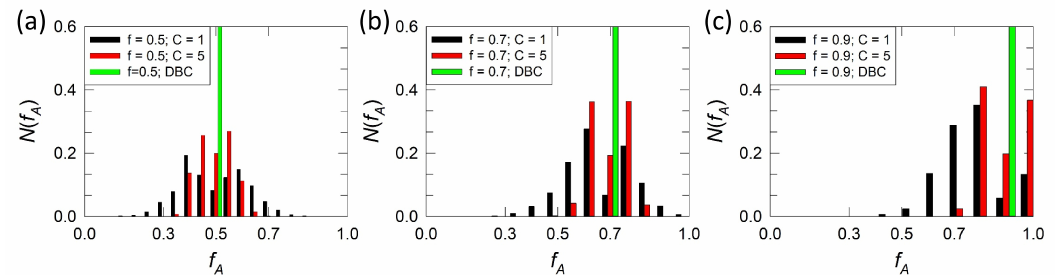
Figure 3. Distribution of chains N ( f A ) as a function of the fraction of A segments that become f A in copolymer chains for ( a ) f = 0.5, ( b ) f = 0.7 and ( c ) f = 0.9. Only gradient copolymer melts with C = { 5,1 } are shown by black and red bars, respectively. Green bar denotes corresponding diblock copolymers with N ( f A ) = 1 .